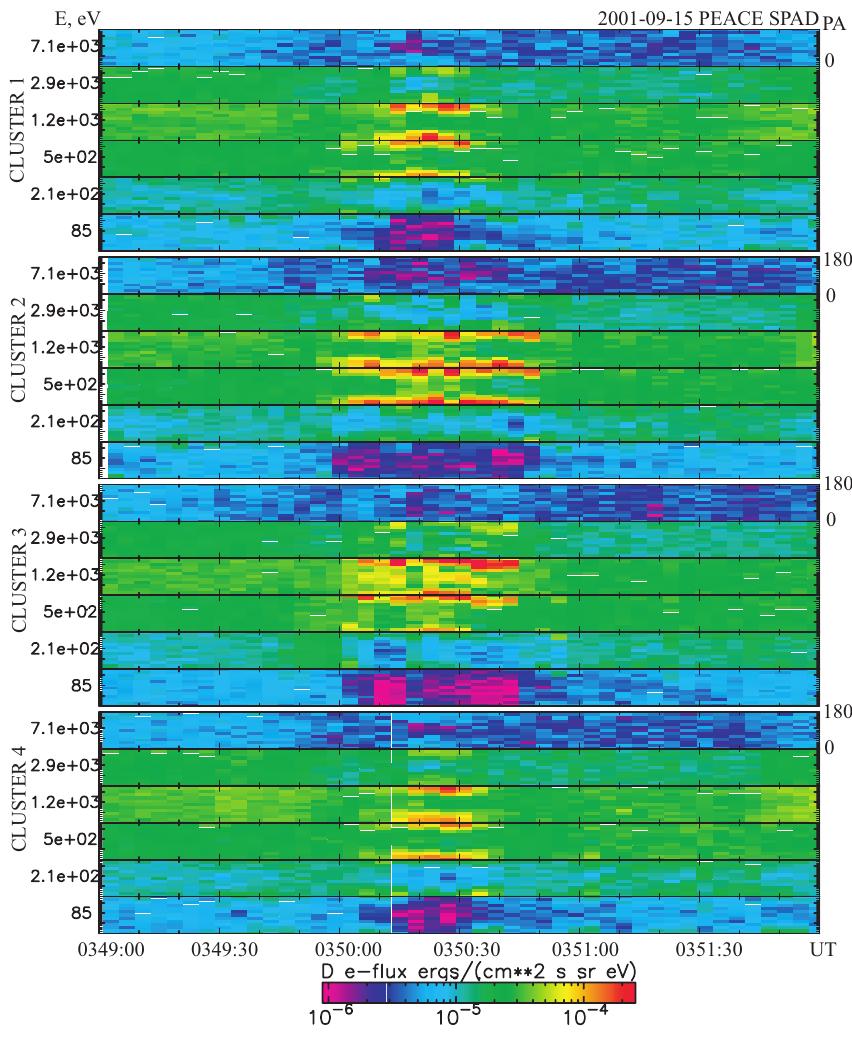
Fig. 10. Cluster PEACE PAD ET spectrograms, interval B